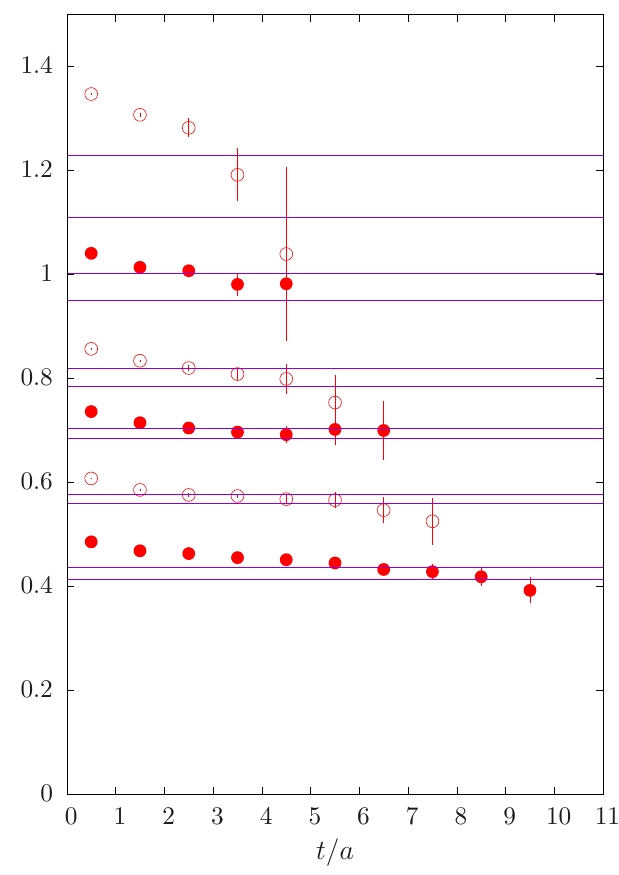
Figure 5 . E(cid:11)ective energies of the ground state Pfa(cid:14)an string in SO(6) at (cid:12) = 46 : 0 for lengths l = 18 ; 22 ; 26 ; 30 ; 36 ; 46 in order. Pairs of lines are